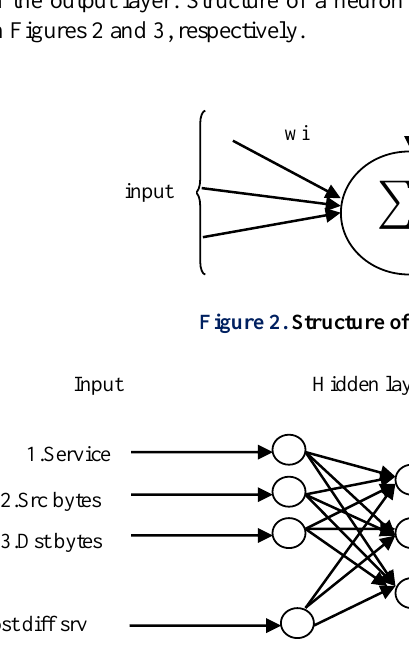
Figure 3. Structure of the used neural